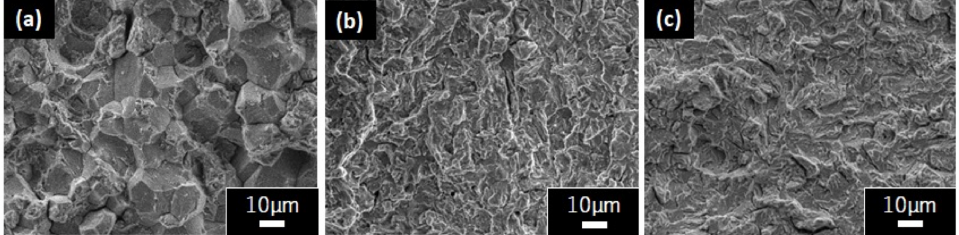
Figure 15. Microscopic fracture surfaces near the notch tip after delayed fracture test; (a) a IQT-C specimen shows intergranular (IG) fracture, (b) a IQT-I specimen shows quasi-cleavage (QC) fracture and (c) a IQT-S specimen also shows quasi-cleavage (QC) fracture.